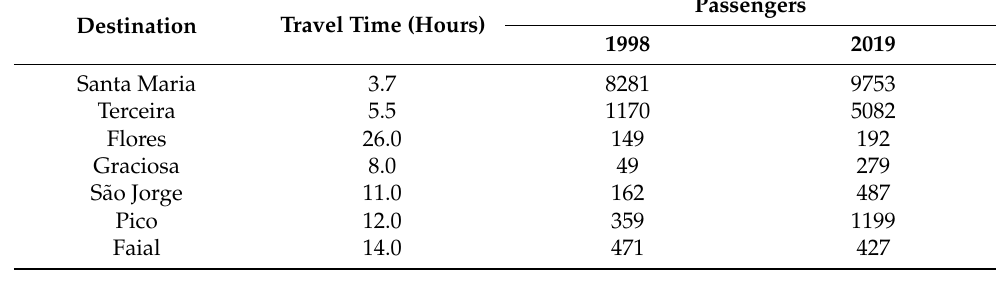
Table 7. Data for maritime connections to S ã o Miguel Island from the rest of the archipelago—for 1998 and 2019.